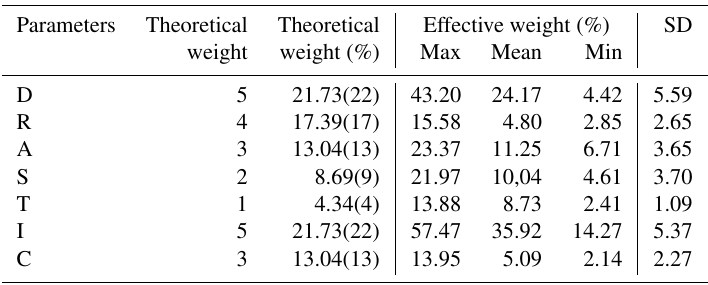
Table 12. Single parameter sensitivity analysis (effective weights).